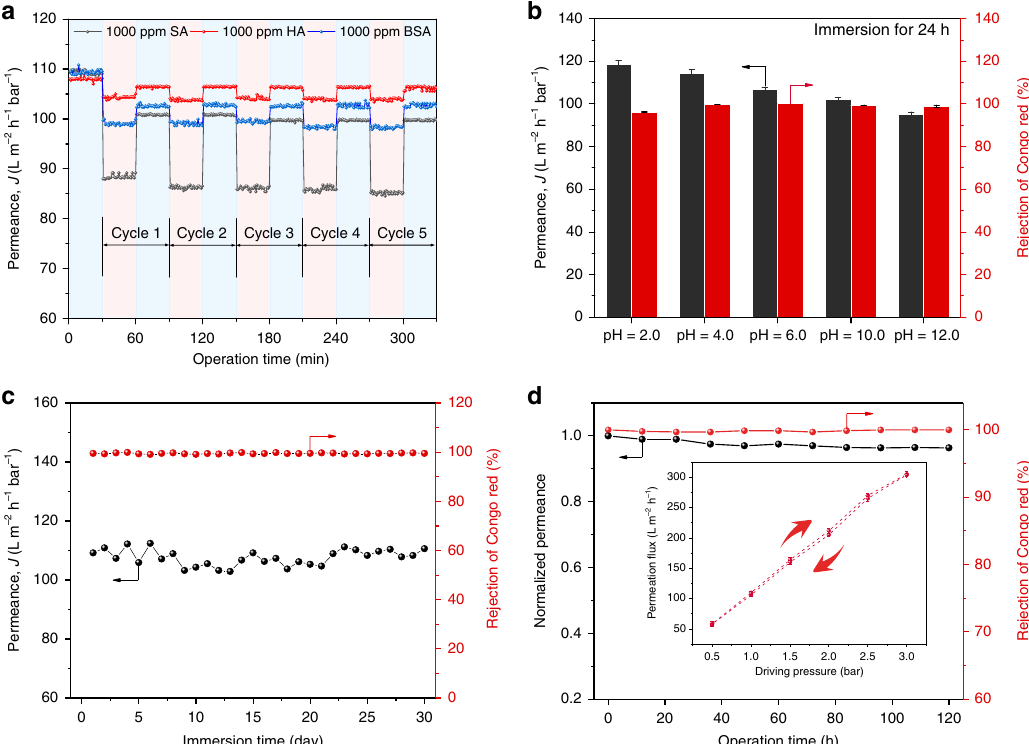
Fig. 4 Stability of MOPM-Fe 3 + /PAN membranes. a Five-stage antifouling measurement of MOPM-Fe 3 + /PAN membrane with 1000ppm of sodium alginate (SA), humid acid (HA) and bovine serum albumin (BSA) solution as feed at 1.0 bar. b Stability performance of MOPM-Fe 3 + /PAN membrane under varied pH conditions by immersing membrane in HCl and NaOH solution for 24 h. T = 18 °C. c Long-term water stability of MOPM-Fe 3 + /PAN membrane (pH = 4.0). d Long-term fi ltration performance of MOPM-Fe 3 + /PAN membrane at 0.5 bar. Inset in d : Permeation fl ux of MOPM-Fe 3 + /PAN membrane in pressure cycling experiment. Error bars represent standard deviations for 3